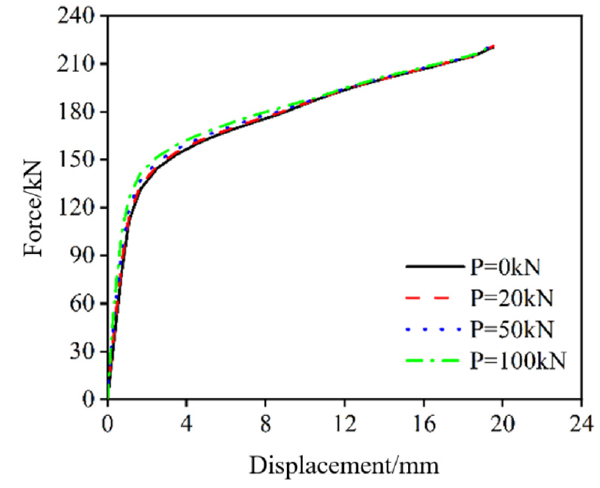
10 of 17 Figure 9. Load–displacement curve comparison of T1. Figure 10. Test and fi nite element model failure mode. 4.2. E ff ect of Preload Force Figures 11 and 12 respectively show the load–displacement and bolt force curves of specimen T1 under di ff erent preload forces. According to the de fi nition in the literature [9], with preload, when the external load is less than the preload, the prying force should be equal to the value of the di ff erence between the bolt force and the preload, that is, Q = B − P; when the external load is greater than the preload, the prying force is equal to the value of the di ff erence between the bolt force and the external load, that is, Q = B − T. From Figure 11, the load–displacement curves overlap, whereas the bolt force has a noticeable di ff erence at the beginning of loading under the in fl uence of di ff erent preload forces; how- ever, the in fl uence of preload force decreases gradually as the external load increases. The